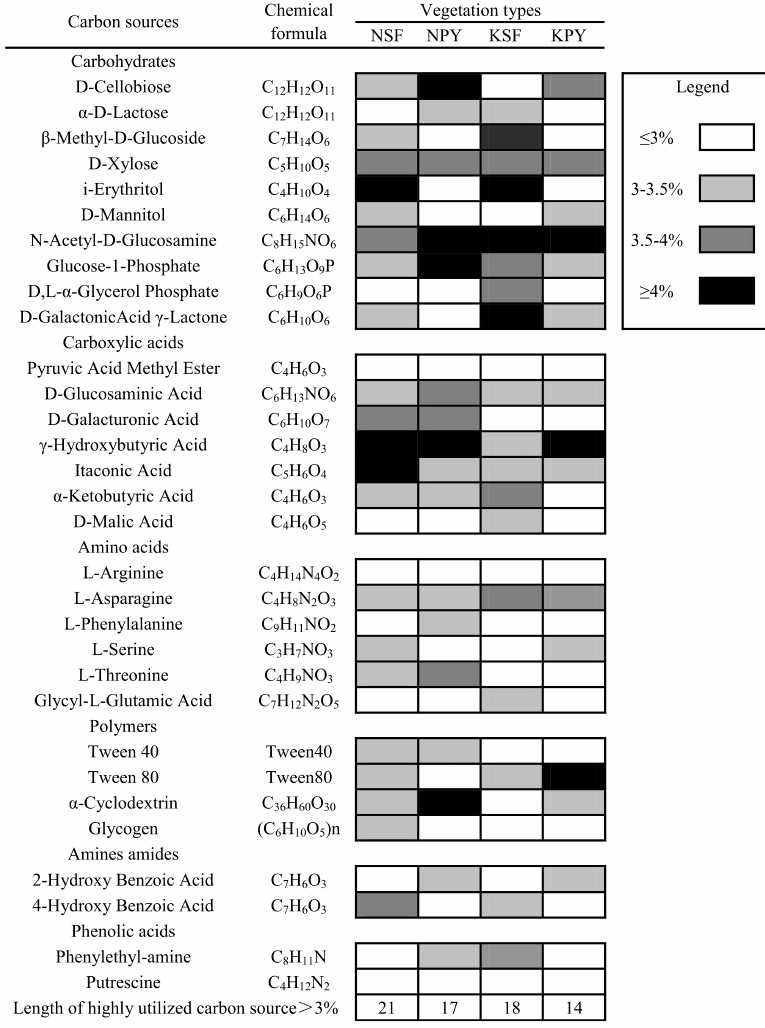
Figure 2. Use pattern of 31 carbon substrates by the microbial community under a Pinus yunnanensis plantation and a secondary forest in non-karst and karst areas in southern China.